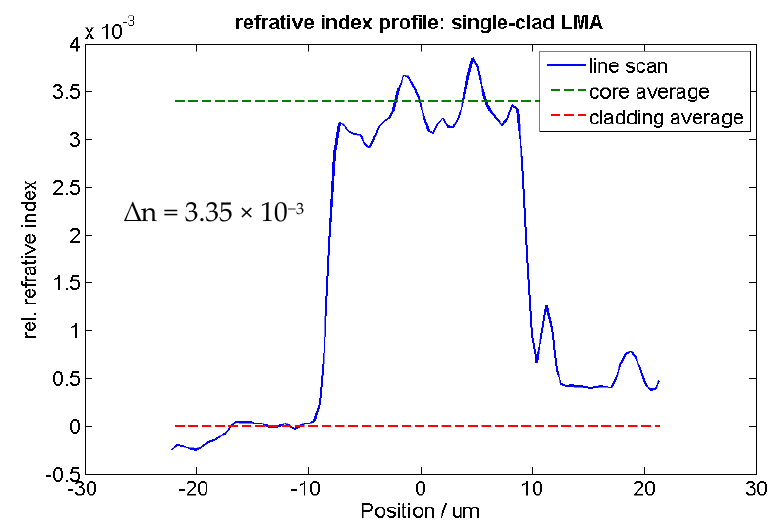
Figure 14. Reflection-based refractive index mapping method [41]: refractive index profile of the single-clad fiber with a ∆ n of 3.35 × 10 -3 [7].